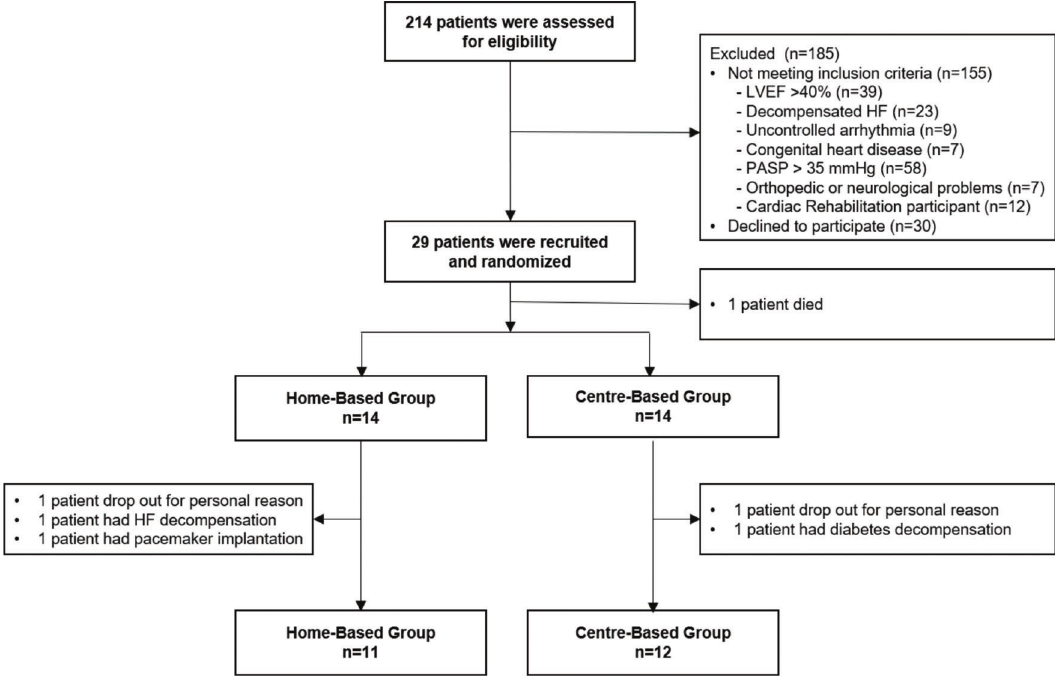
Figure 2 - Recruitment and intervention flowchart. HF, heart failure; LVEF, left ventricular ejection fraction; PASP, pulmonary artery systolic